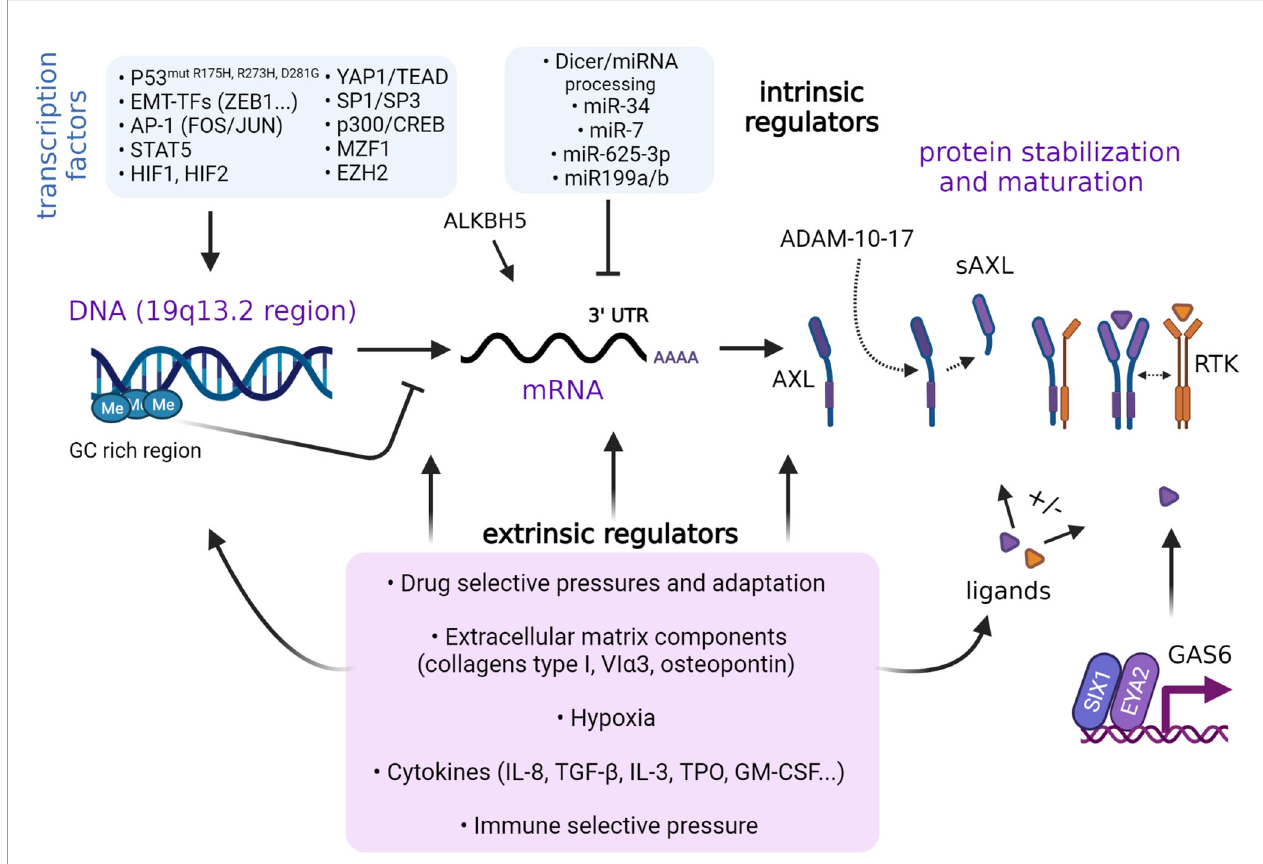
FIGURE 2 | Regulation of AXL expression. Regulation of AXL expression is context-dependent and involves intrinsic and extrinsic factors. Various transcription factors and epigenetic events such as DNA methylation have been identi fi ed to regulate AXL expression. AXL protein synthesis is partly regulated by miRNAs. The stabilization of AXL can be affected by ligand binding and interactions with other RTKs. Cleavage of AXL extracellular domain into a soluble form by the action of A Disintegrin And Metalloprotease (ADAM) 7-10. Extrinsic factors, stress, and microenvironmental conditions may also control the different steps. The role of AXL as a sensor of the environmental cues in speci fi c cancer systems and at various stages of cancer progression remains to be fully